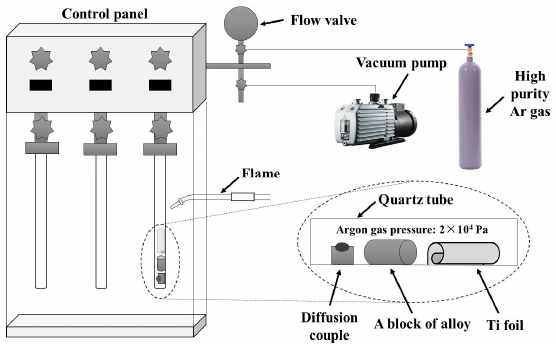
Figure 2. Schematic of the vacuum sealing process.